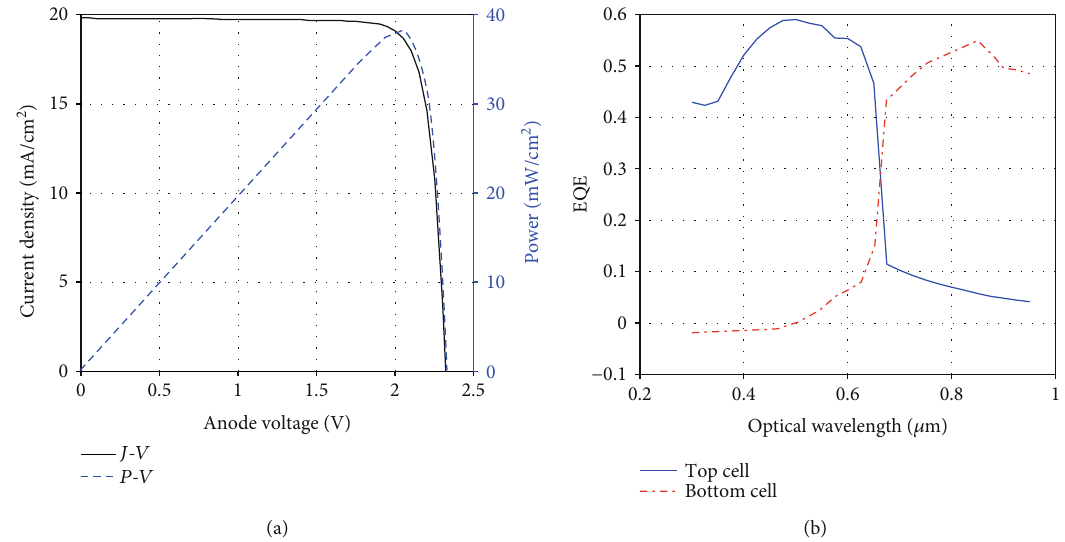
Figure 11: Simulation results of the optimized DJ solar cell using (Al